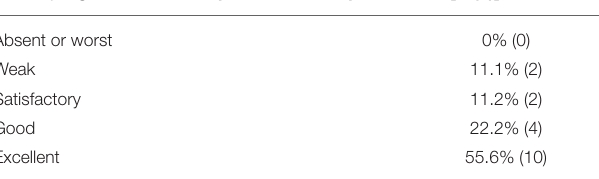
TABLE 4 | Veterinarian global judgement of the improvement compared to D0 ( n = 18).